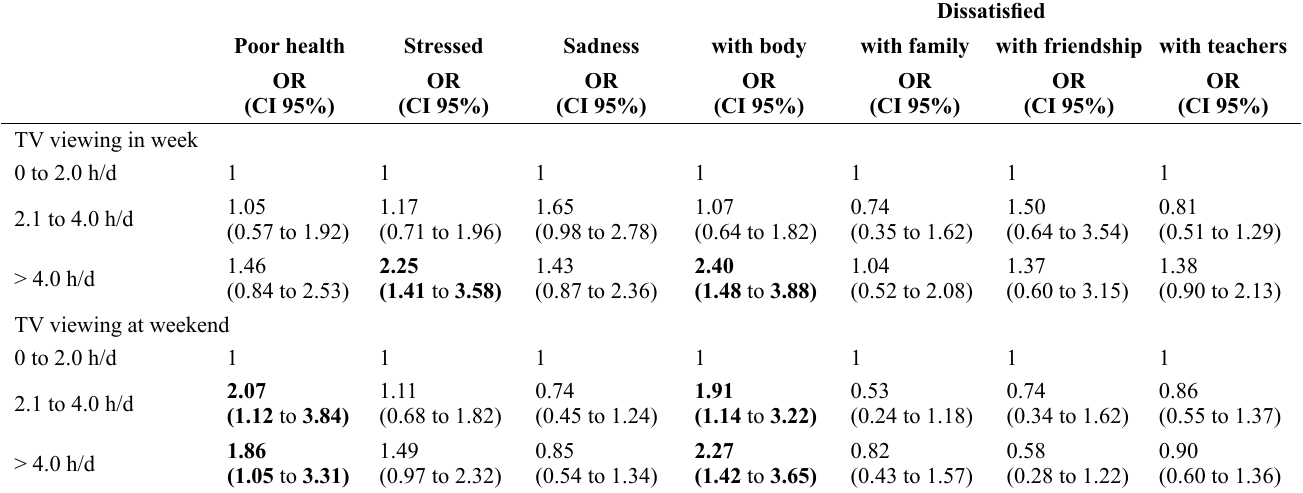
Table 2. Association between sedentary behavior contexts and indicators of mental health and social relationships in boys (Londrina 2011, Brazil; n =